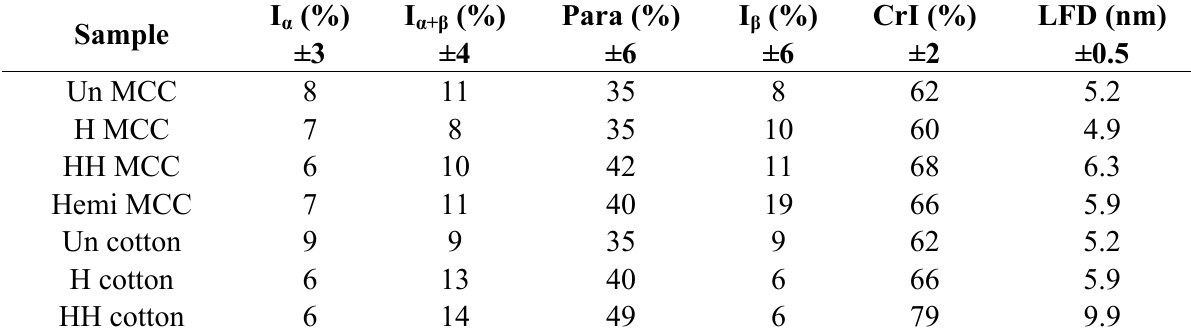
Table 1. Crystalline ultrastructural results for line-fitting of 13 C CP/MAS spectra of microcrystalline cellulose (MCC) and cellulose from cotton swaps after various treatments used to isolate cellulose from whole biomass samples. The ± value represents thee standard deviation of typical variation associated with the measurement. Un = untreated, Hemi = hemicellulose removal by acid hydrolysis, H = holocellulose pulped, HH = holocellulose pulped and hemicellulose removal by acid hydrolysis. The plus-minus values represent thee standard deviations of typical variation associated with the measurement.